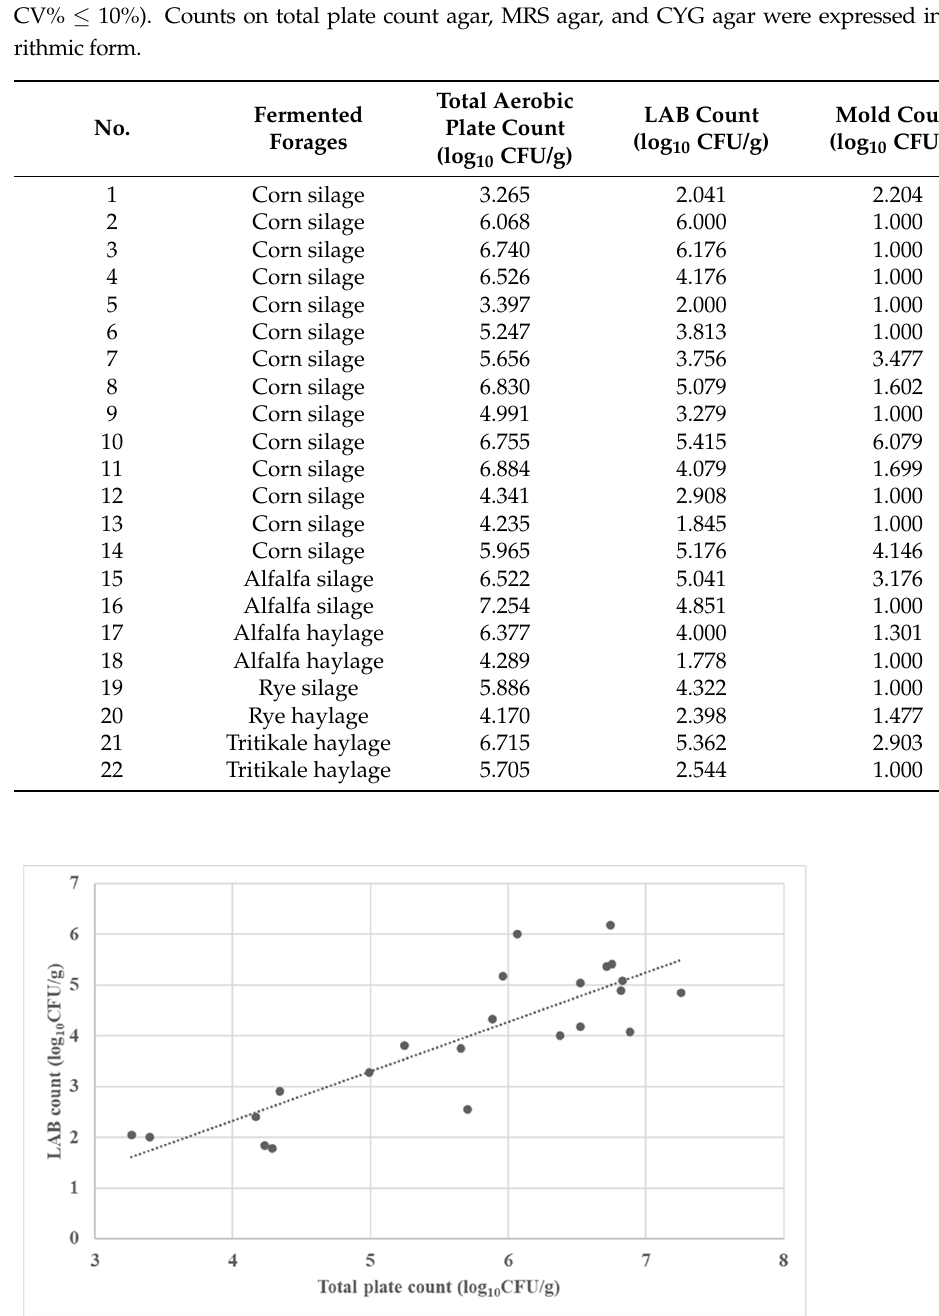
Table 2. Characterization of the microbial composition of the studied fermented forages ( n = 3;